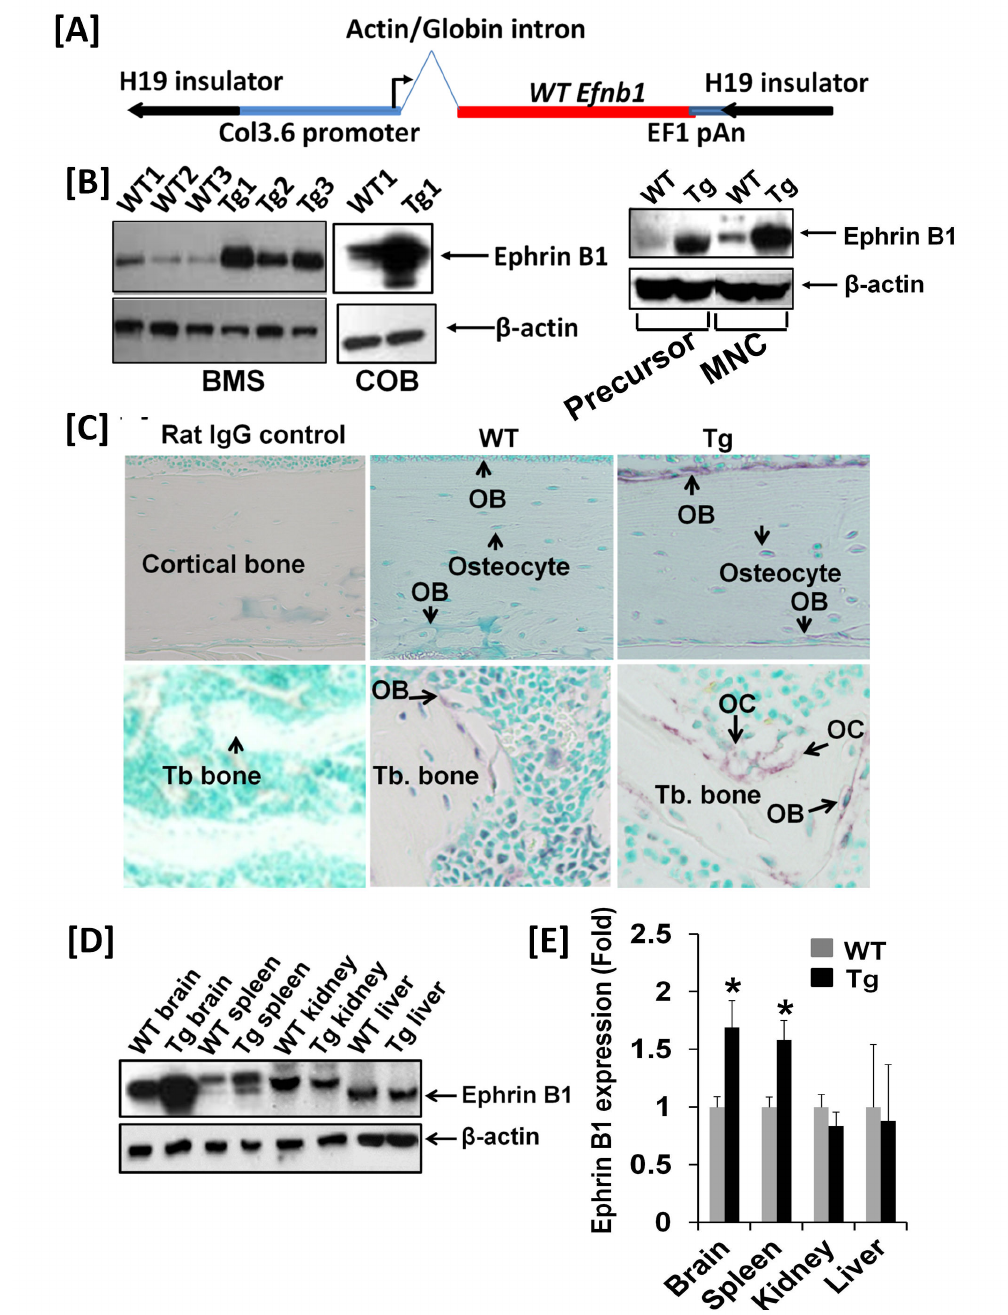
Figure 1. Col3.6-Tg efnb1 mice express high levels of ephrin B1 in the bone. [A] A schematic diagram of the transgene expression cassette. [B] Western blots show ephrin B1 overexpression in calvarial osteoblasts (COB), differentiated bone marrow stromal (BMS) cells and osteoclasts. BMS cells were differentiated in the presence of ascorbic acid and beta-glycerophosphate for 6 days prior harvesting for Western blot analyses. Osteoclast precursors derived from the spleen of WT and Tg mice were differentiated into multinucleated cells (MNCs) by 5-day treatment of M-SCF and RANKL. [C] Immunohistochemistry shows ephrin B1 overexpression in tibial periosteal, endosteal osteoblasts, osteocytes and trabecular surface osteobasts and osteoclasts. [D] A representative image of a Western blot shows ephrin B1 expression in the brain, spleen, kidney and liver in WT and TG mice. [E] Quantitative data of ephrin B1 expression from 3 independent experiments. Data are means ± SEM for N = 3. A star represents statistical significance (P < 0.05) when compared to WT littermate controls. doi: 10.1371/journal.pone.0069051.g001 PLOS ONE |